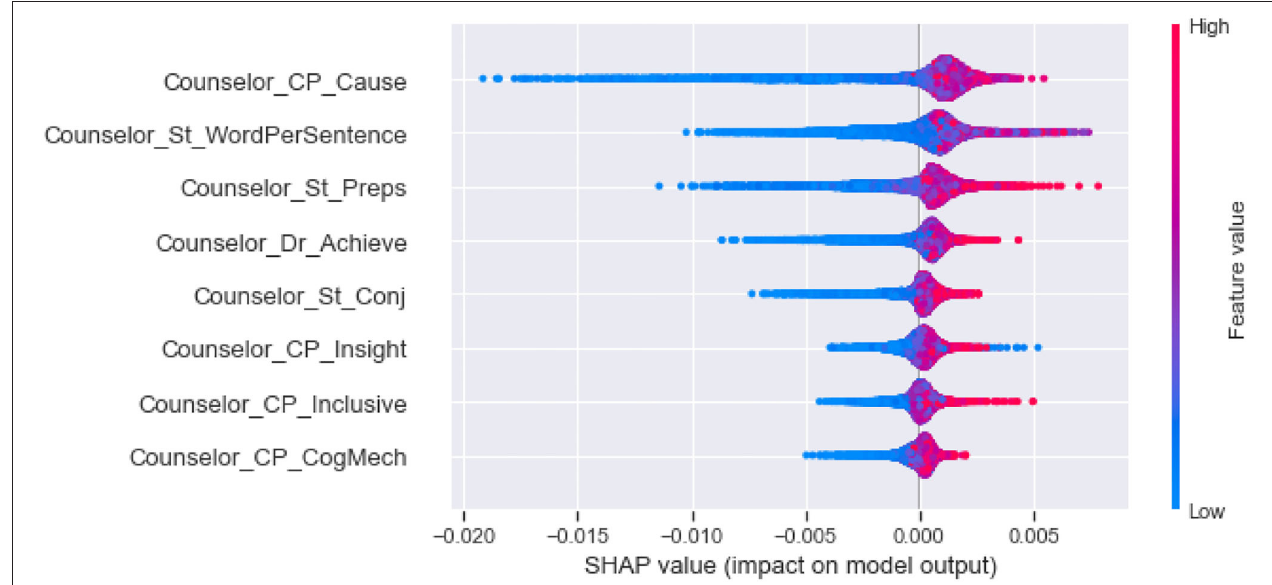
FIGURE 6 | The SHAP summary plots about the adjustment to the predicted in perceive helpfulness numbers (x-axis) for each of the third type